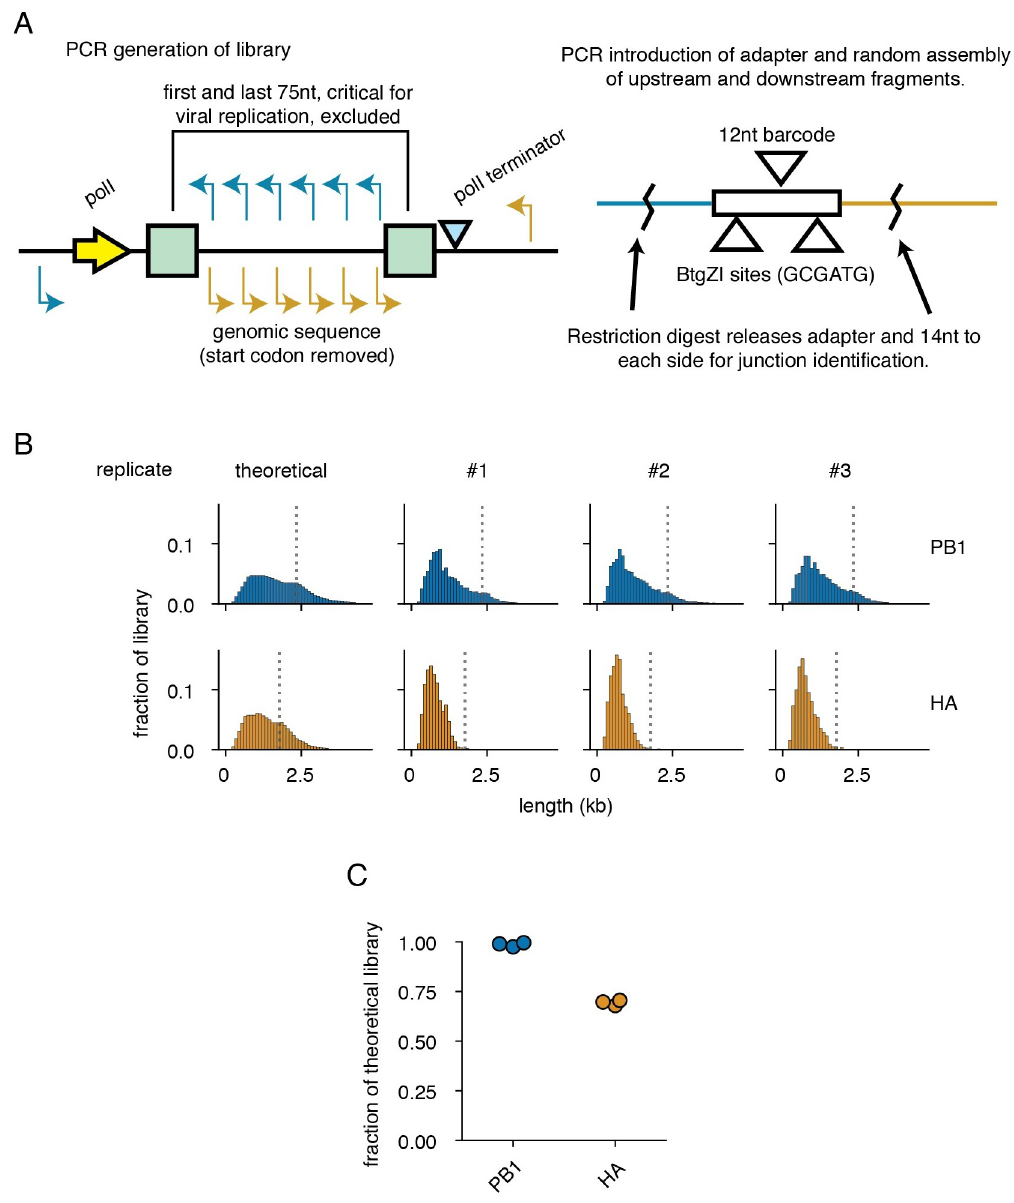
Fig 1. A PCR-based strategy for exploring length-dependent phenomena in viral libraries. (A) As templates for each library, we used vectors encoding each segment under control of a polymerase I-dependent system for generating authentic viral RNAs. For each library, a set of staggered primers were used in individual PCR reactions with an external primer. Further PCR was used to append a 57nt adapter with a random, 12nt, barcode. Products were then randomly combined in a pooled Gibson assembly reaction. To link barcodes to duplication or deletion junctions, barcodes and flanking regions were freed from the plasmid pool with a BtgZI digest and sequenced. Primers used to generate the library are in S1 File. (B) Theoretical and actual length distributions of libraries. Lengths do not include the 57nt adapter. Bins in this and all other panels are 100nt in length, numbers represent the right edge of each bin. Dotted lines show the length of wild-type PB1 and HA. (C) Libraries contain most of the theoretical diversity. Each point represents a single